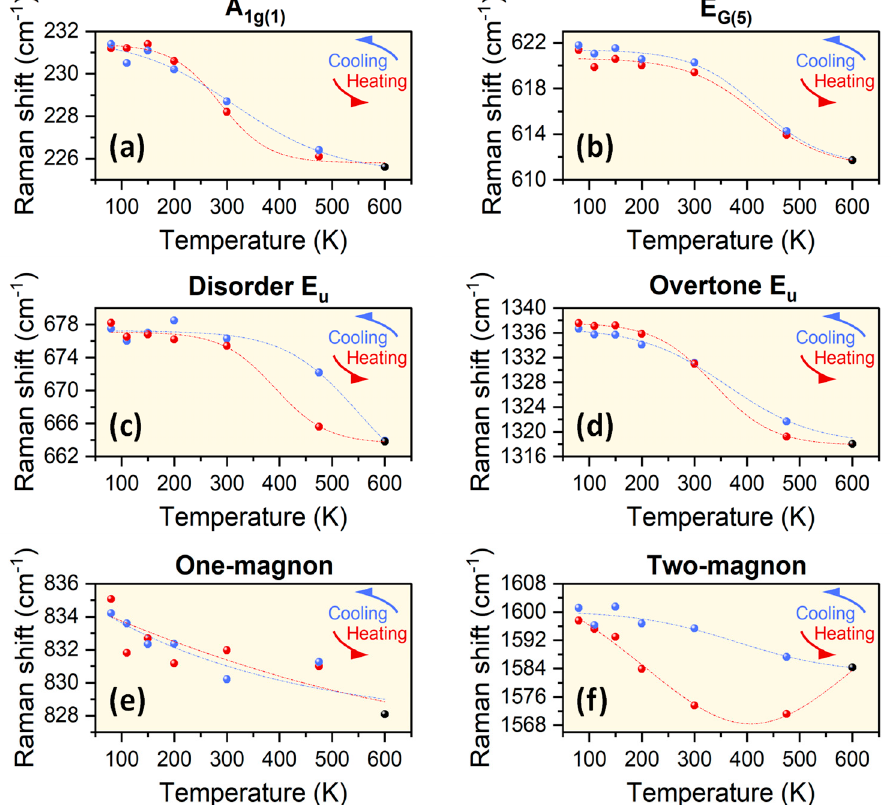
Figure 5. Heating (red color) and cooling (blue color) curves of the Raman shift positions between 80 and 600 K related to the modes: ( a ) A 1g(1) , ( b ) E g(5) , ( c ) disorder E u , ( d ) overtone E u , ( e ) one-magnon, and ( f ) two-magnon mode of the nanoparticulated hematite coating. The black symbol represents the returning temperature (600 K).